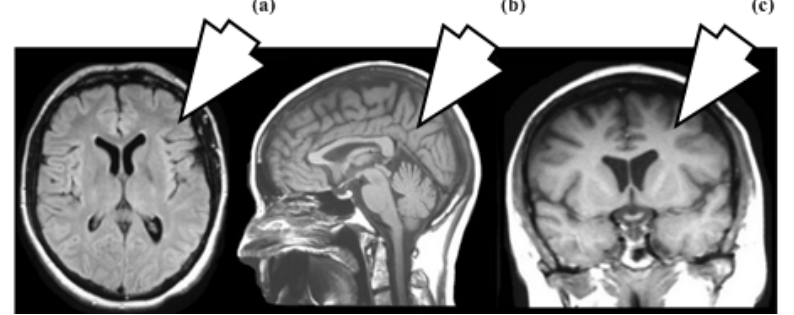
Figure 2. ( a ) Axial, ( b ) Sagittal, ( c ) Coronal